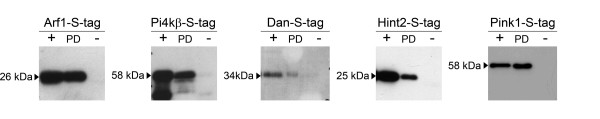
GST-pulldowns. GST pulldowns were performed to validate NCS-1/NBP interactions. A human NCS-1-GST fusion protein was used to pull down S-tagged zebrafish NBPs. In each panel, the left (+) lane contains a bacterial lysate expressing the designated S-tagged NBP, the middle lane (PD), contains NBPs pulled down from bacterial lysates after incubation with the NCS-1-GST fusion protein, and the right lane (-) shows proteins pulled down from lysates after incubation with GST alone. Blots were probed with an HRP-conjugated S-tag antibody to detect each S-tagged NBP. Molecular weights (kDa) of S-tagged NPB fragments are indicated to the left of each panel.